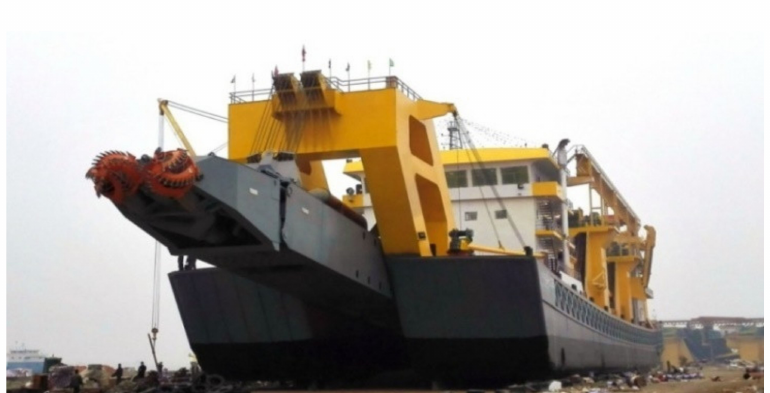
Figure 2. The ordinary double cutter